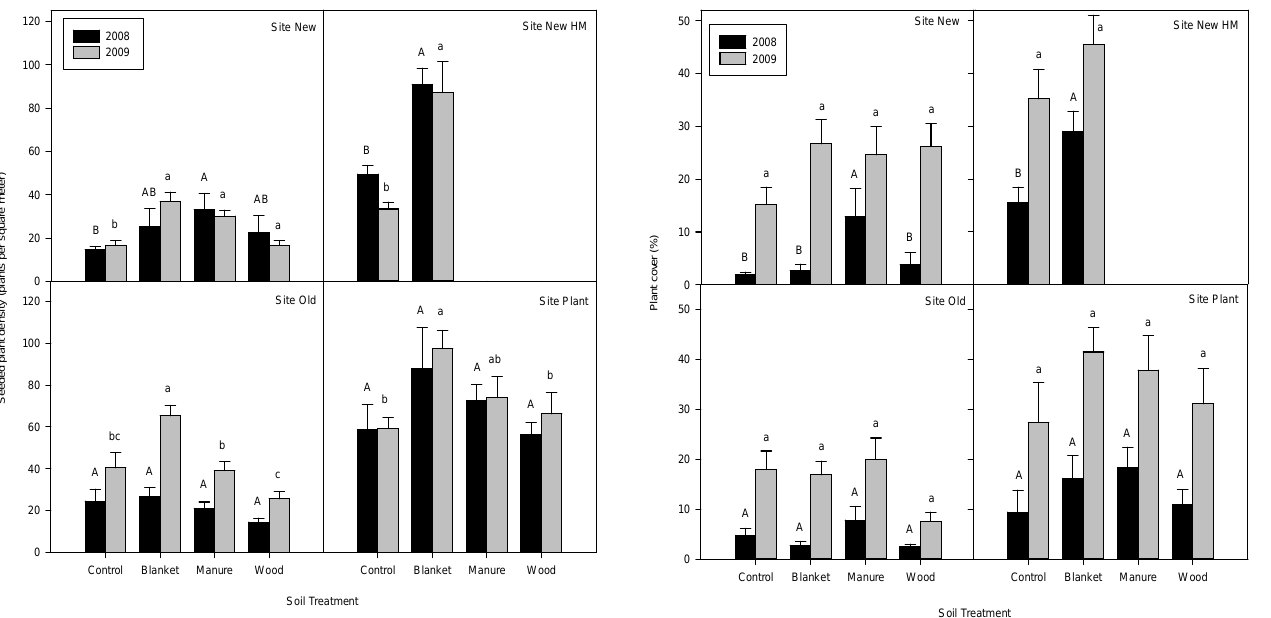
Fig. 1. Mean seeded plant density at each soil treatment and site in Fig. 2. Mean percent plant cover at each soil treatment and site in 2008 and 2009. Letters indicate significant differences among soil Figure 2. Mean percent plant cover at each soil treatment and site in 2008 and 2009. Letters 2008 and 2009. Letters indicate significant differences among soil Figure 1. Mean seeded plant density at each soil treatment and site in 2008 and 2009. treatments in the same year; upper case letters for 2008 and lower treatments in the same year; upper case letters for 2008 and lower indicate significant differences among soil treatments in the same year; upper case Letters indicate significant differences among soil treatments in the same year; case letters for 2009. Bars indicate standard error. case letters for 2009. Bars indicate standard letters for 2008 and lower case letters for 2009. Bars indicate standard error. upper case letters for 2008 and lower case letters for 2009. Bars indicate standard error.